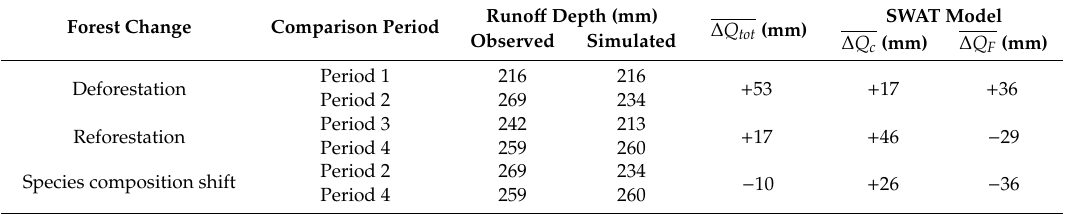
Table 3. The contribution evaluation of climate variability and forest change on runo ff